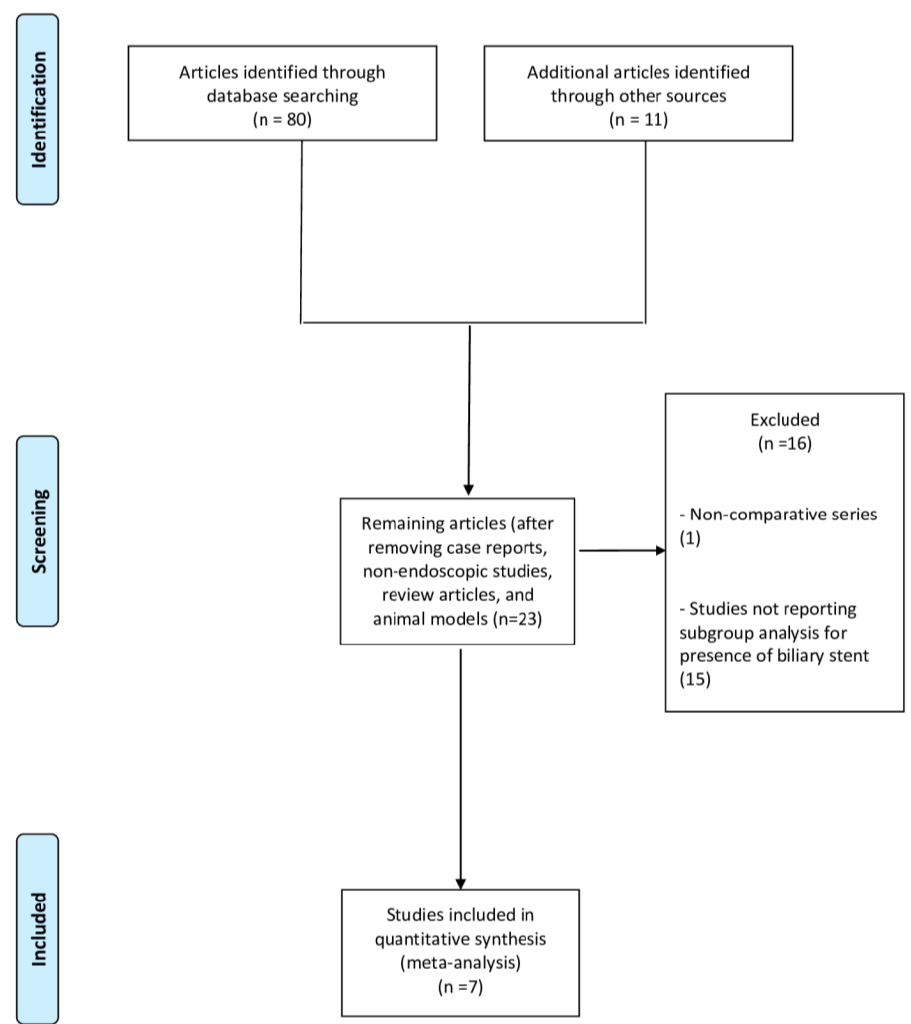
Figure 1. Flow chart of the included studies.